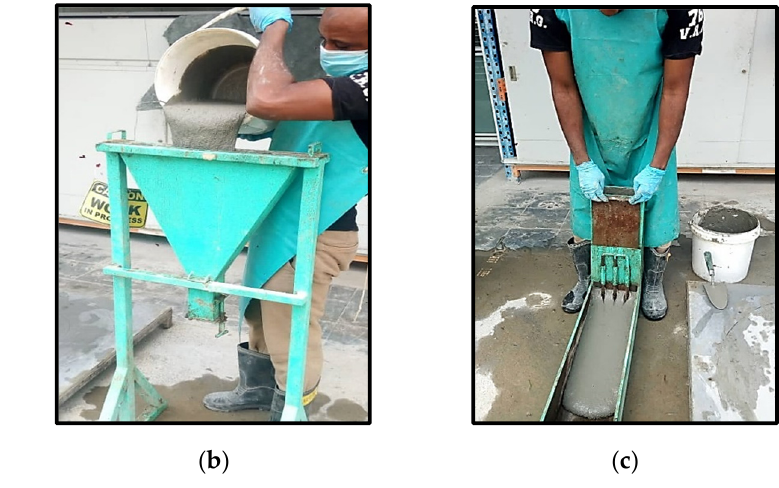
Figure 3. ( a ) Slump flow test; ( b ) V-funnel test; ( c ) L-box